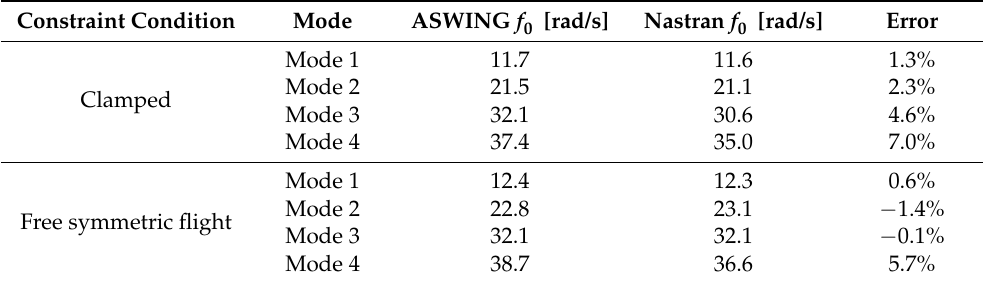
Table 5. Comparison of the first four natural modes for PARSIFAL test case. Constraint Condition